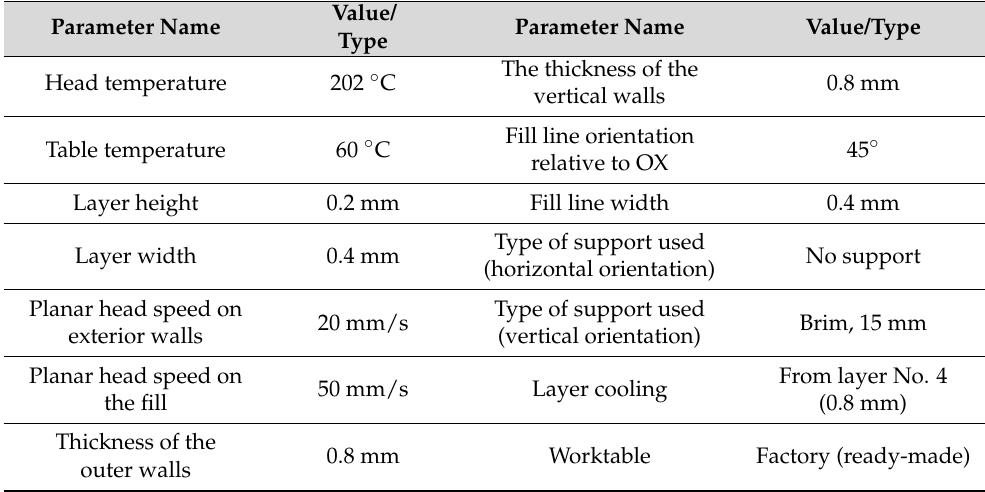
Figure 6. Influence of the density and type of filling for the strength of R m (R m ) and R 02 (R02) in the uniaxial tensile test for the type of filling grid (own elaboration, based on [16]). Table 1. Constant printing parameters for the Ender 3 printer and Ultimaker